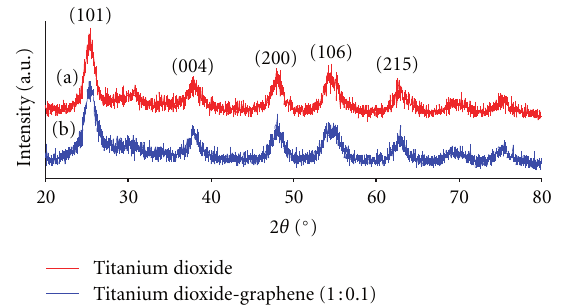
F 2: XRD spectra of (a) titanium dioxide, (b) TiO